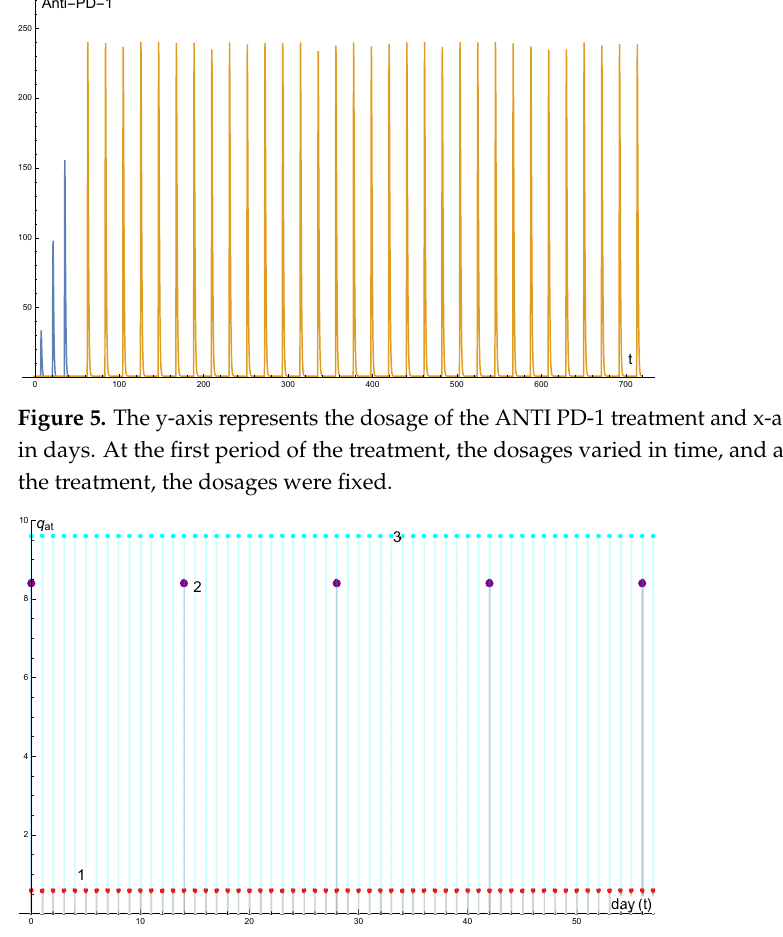
Figure 6. The y-axis (divided by 100) represents the dosage of the drug and x-axis represents the time in days. Discrete plot 1: drug: cobimetinib, 60 mg. Discrete plot 2: drug: atezolizumab, 840 mg. Discrete plot 3: drug: vemurafenib, 960